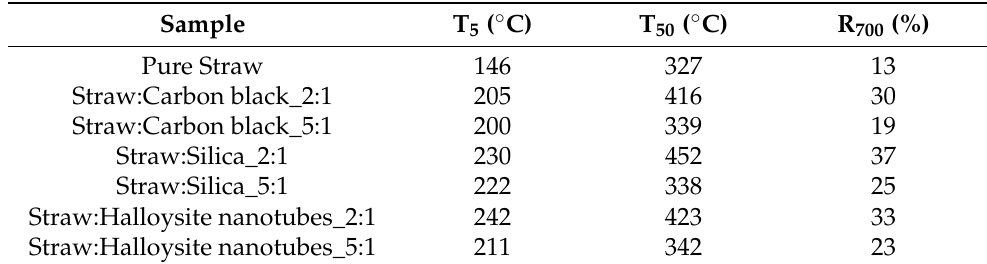
Table 3. Thermal parameters of fillers: temperature of 5% weight loss (T 5 ), temperature of 50% weight loss (T 50 ), the solid residue after combustion (R 700 ).